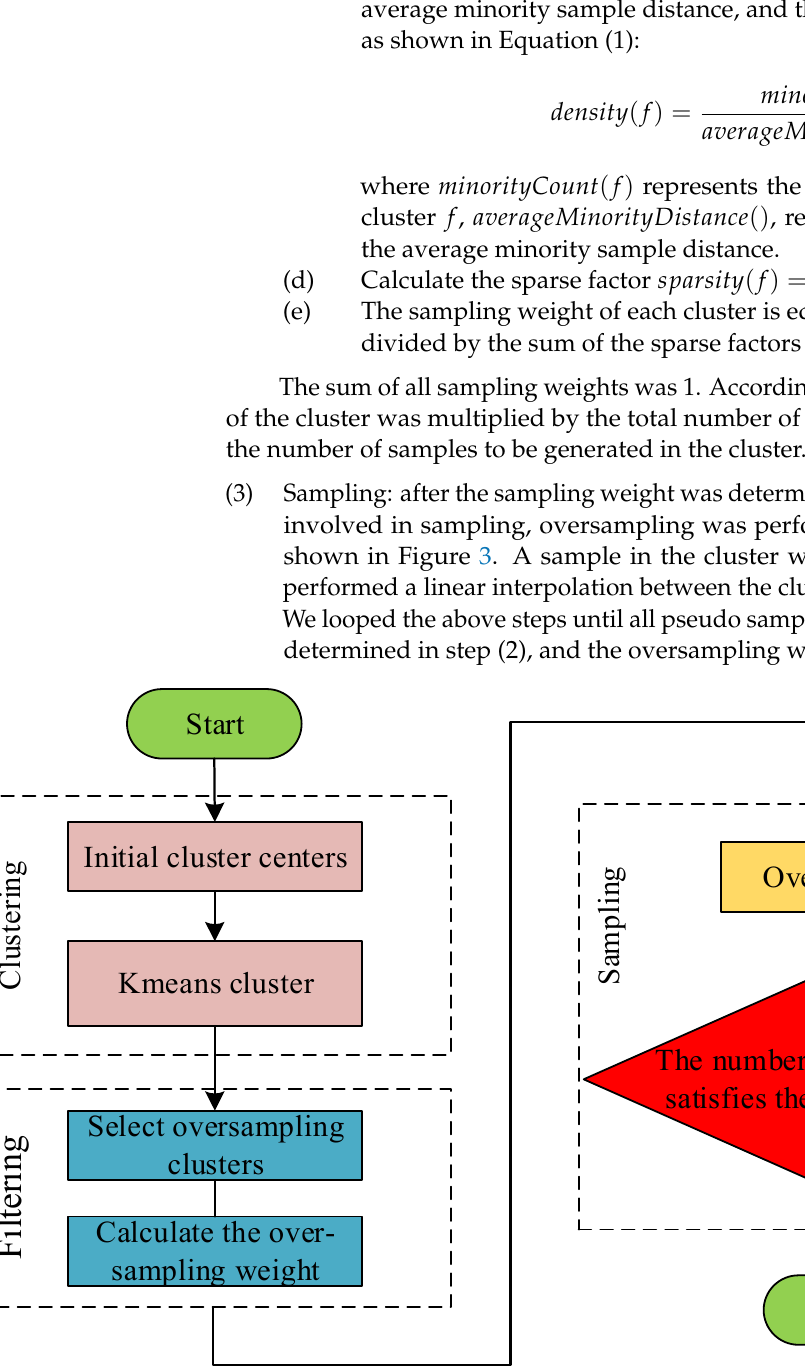
Figure 2. The execution process of the CIKS algorithm.